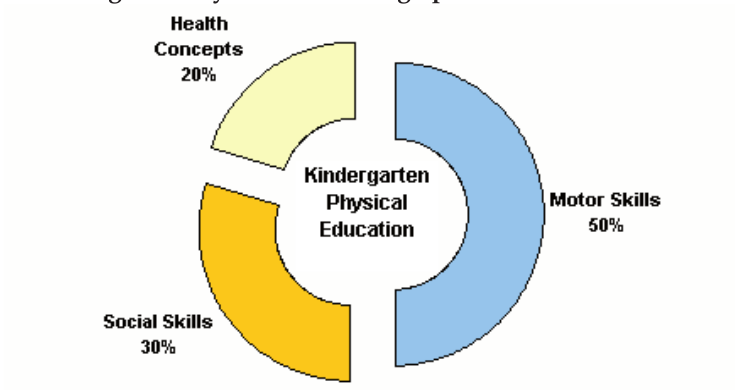
Fig. 1. Kindergarten Physical Education